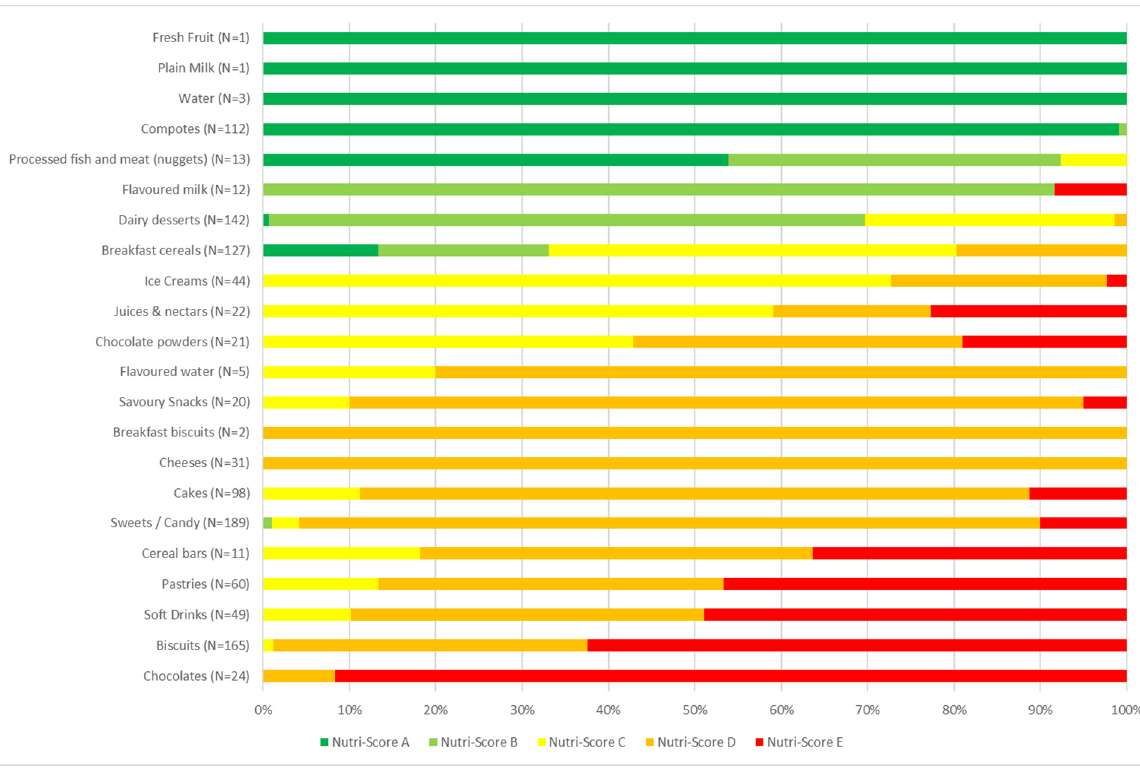
Figure 2. Graphical representation of the distribution of food groups in the sample ( n = 22) by Nutri-Score group ( n = 1152).